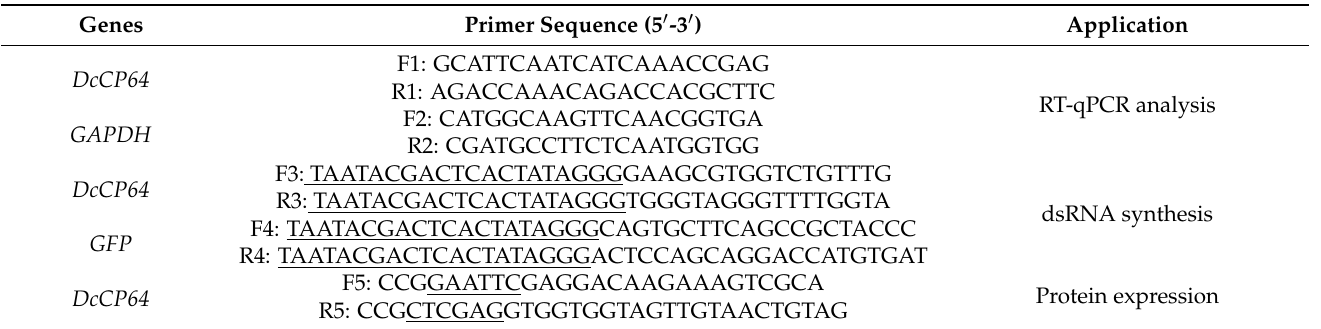
Table 1. Primers used in this